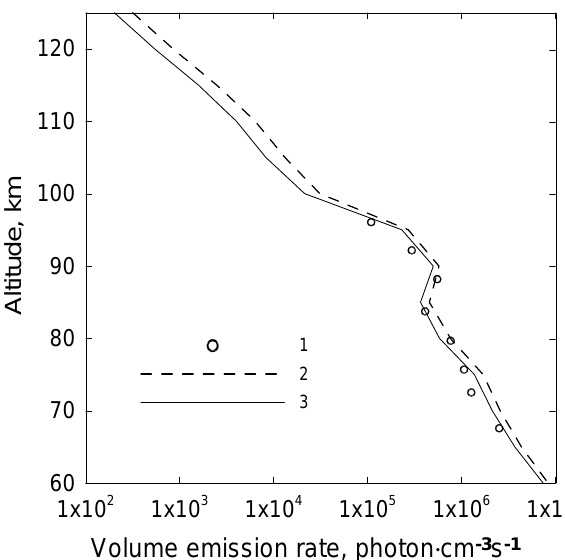
Fig. 7. Volume emission rate at 762nm. Circles (1) – experimental data of METEORS (Mlynczak et al., 2001). Curves – calculations for the conditions of experiment METEORS: 2 – in accordance with the model of Mlynczak et al. (1993); 3 – in accordance with our model.